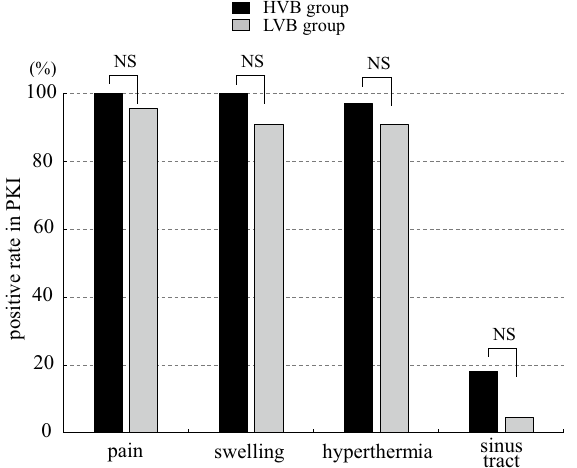
Figure 5. Frequency of local findings according to virulence of causative bacteria in periprosthetic knee infection (PKI). The significant difference of the frequency of each local finding was not shown between